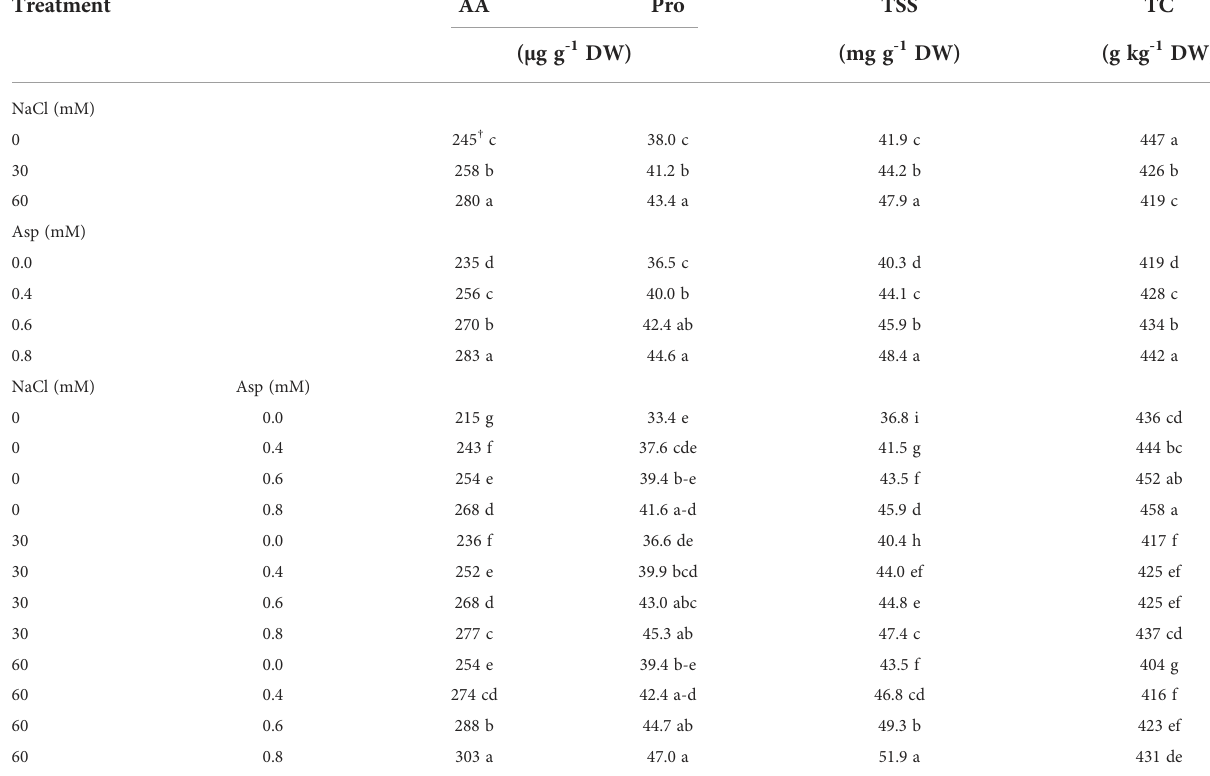
TABLE 2 Effect of aspartic acid (Asp) on compatible solute accumulation (amino acids; AA, proline; Pro, total soluble sugar; TSS, and total carbohydrates; TC) in wheat plants grown under salt stress (NaCl) for 60 days.